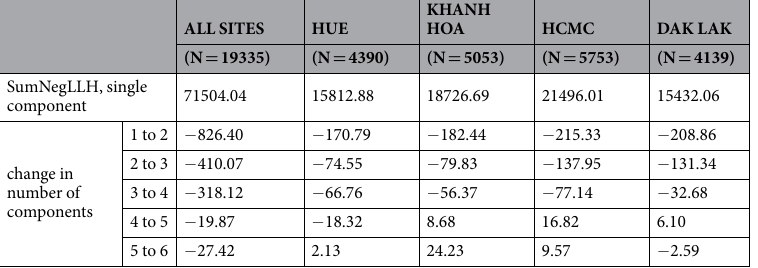
Table 1. Change in BIC values as the number of normal distributions in the mixture increases from one to six for 2009 H1N1, for the aggregated data as well as the individual collection sites. The values of the negative sum of the log likelihood were weighted to adjust for age and gender according to the Vietnam national housing census in 2009. The first row shows the exact values of sum of the negative log-likelihoods